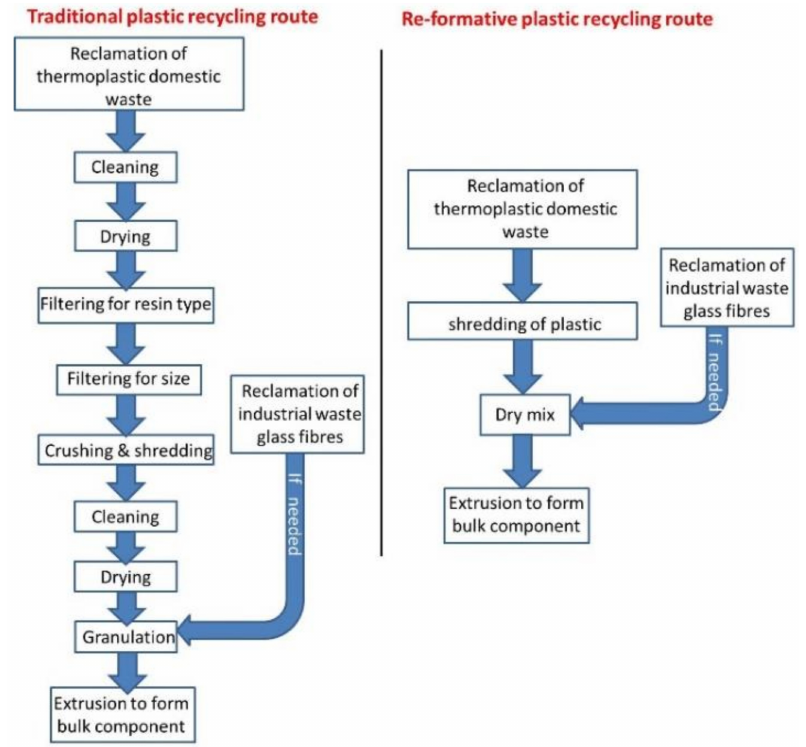
Figure 1. A schematic of the traditional plastic recycling process and the novel re-formative